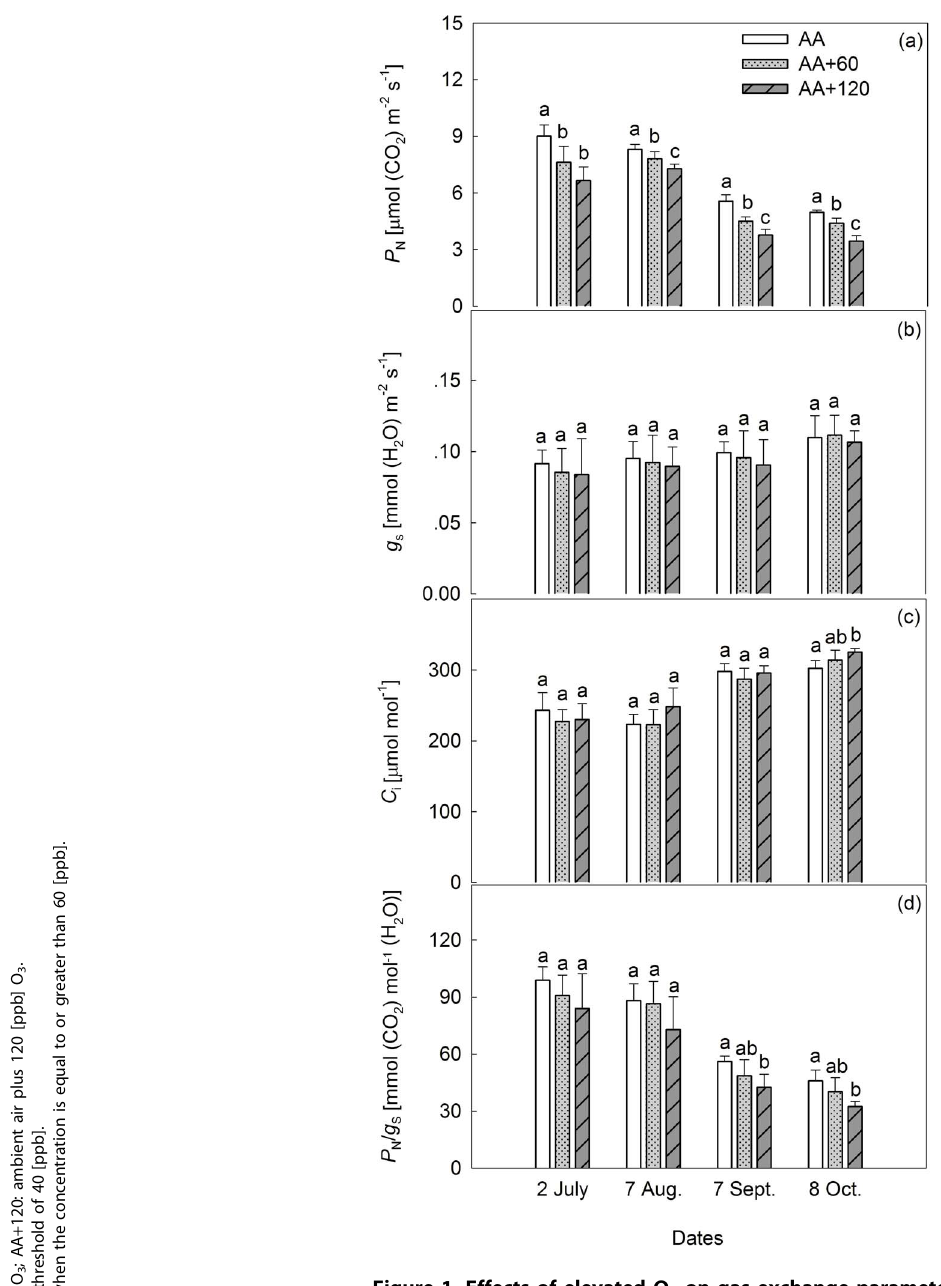
Figure 1. Effects of elevated O 3 on gas exchange parameters. Vertical bars represent average levels and distinct letters indicate significant differences among O 3 regimes ( n =6) (AA: ambient air; AA + 60: ambient air plus 60 [ppb] O 3 ; AA + 120: ambient air plus 120